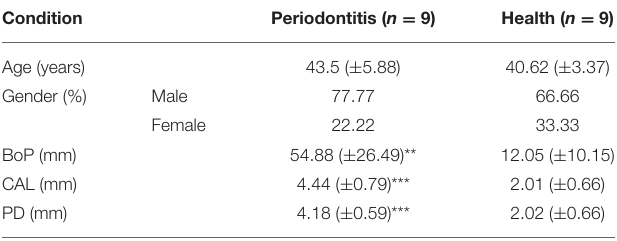
TABLE 1 | Clinical characteristics of the study